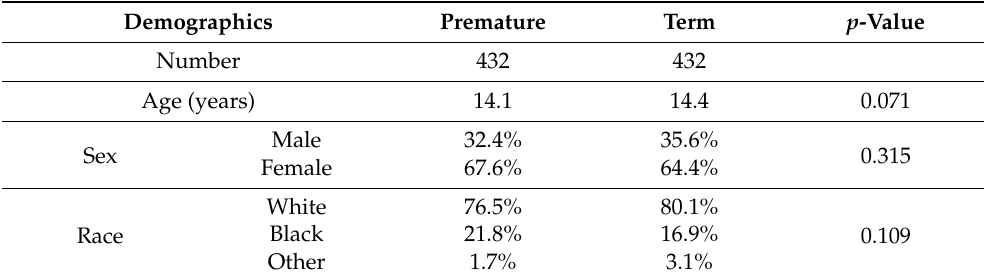
Table 1. Demographics of premature and term AIS patients who underwent PSF from 2012–2016 propensity-score matched for age, sex, and levels fused.